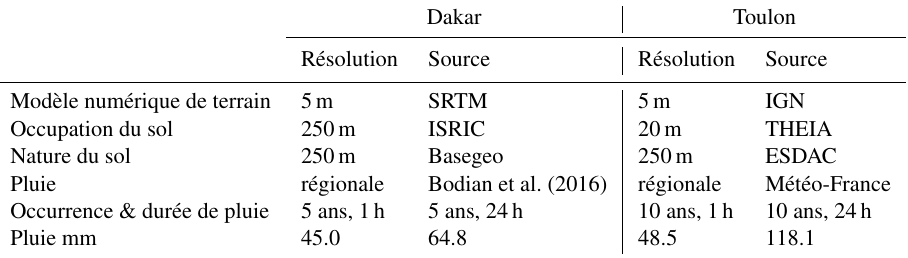
Tableau 1. Caractéristiques des données utilisées dans la modélisation IRIP. Dakar Toulon Résolution Source Résolution Source Modèle numérique de terrain Occupation du sol ISRIC Nature du sol